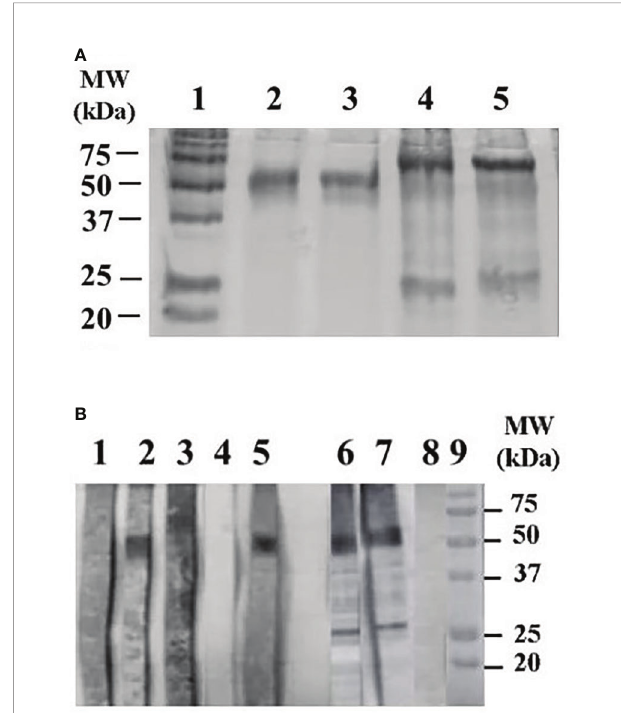
FIGURE 1 | (A) 12% SDS-PAGE gel of CHO- and E. coli-rPvs 48/45 proteins stained with Coomassie blue. Lane 1, molecular weight markers. Lane 2 and 3, CHO- rPvs 48/45 protein (~ 50 kDa) under non-reducing and reducing conditions (0.05 M dithiothreitol) respectively. Line 4 and 5, E. coli - rPvs 48/45 proteins (~ 60 kDa) under non-reducing and reducing conditions, respectively. (B) Western blot analysis under non-reducing conditions of the CHO- rPvs 48/ 45 protein against PBS solution. Lane 1, Normal human sera, lane 2 sera from P. vivax malaria immune subject, lane 3, Normal monkey plasma, lane 4, Blank, lane 5, monkey plasma immunized with E coli-rPvs 48/45 from a previous study (25). Lane 6, 7 and 8 western blot analysis under non- reducing conditions of the E. coli-rPvs 48/45 protein using a mouse monoclonal, a primate polyclonal anti- rPvs 48/45 antibody and Normal monkey plasma respectively. Lane 9, molecular weight